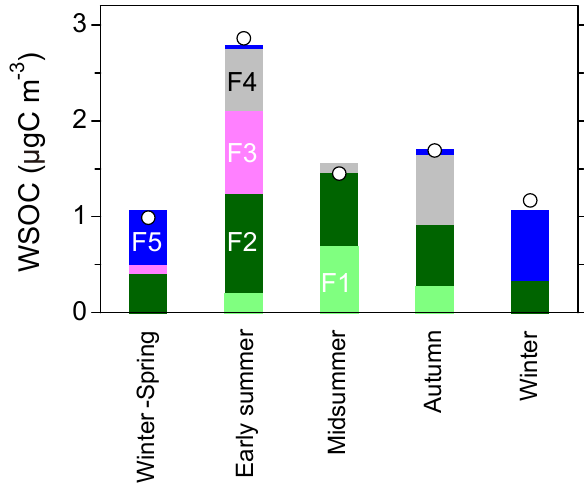
Fig. 4. Estimated relative contributions of different sources to WSOC concentrations resolved by PMF in each season. Open cir- cles indicate the average concentrations of the measured